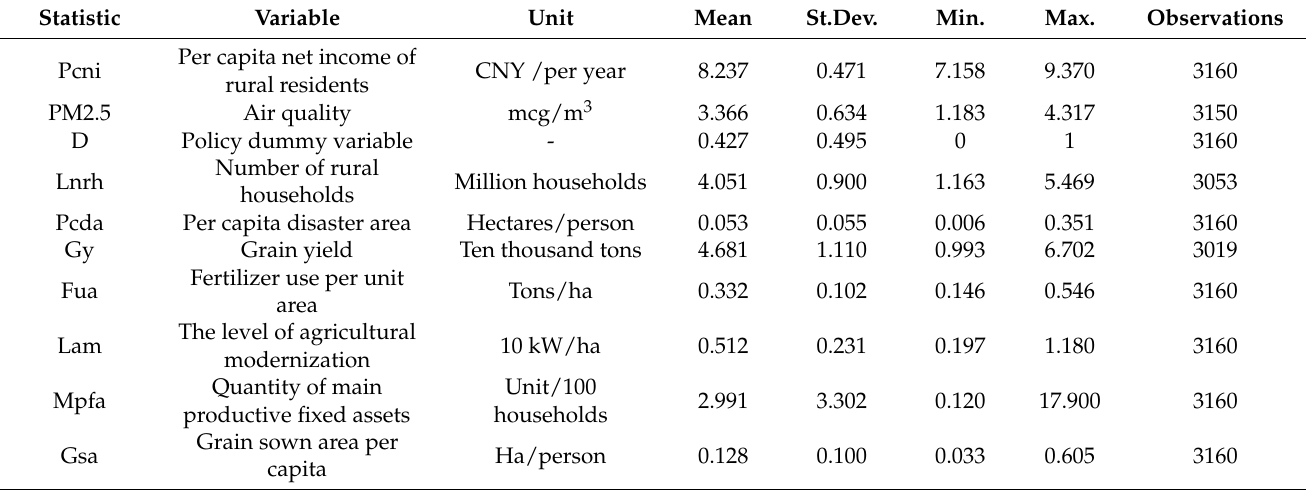
Table 1. Descriptive statistics of main